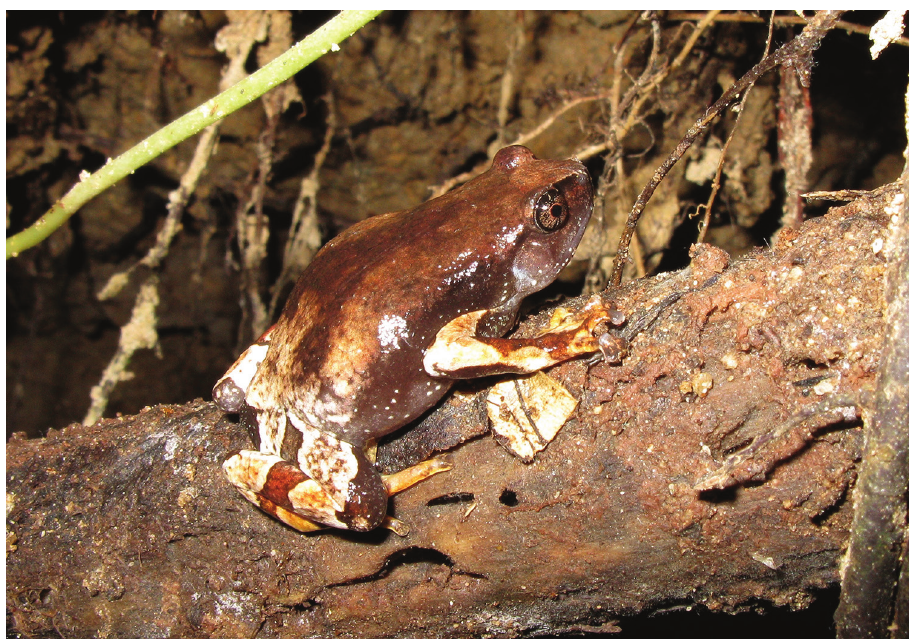
Figure 23. Kaluola sp. female (KU 319451) from 1900 masl, Mt. Balatukan, Municipality of Gingoog City, Misamis Oriental Province. Photo: